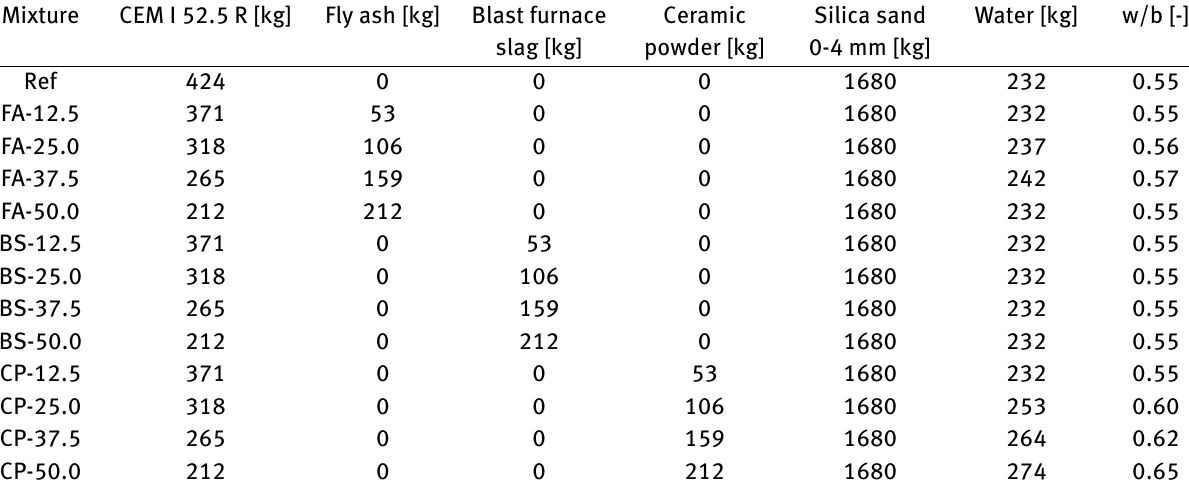
Table 1: Composition of studied concrete screeds [kg m −3 ].